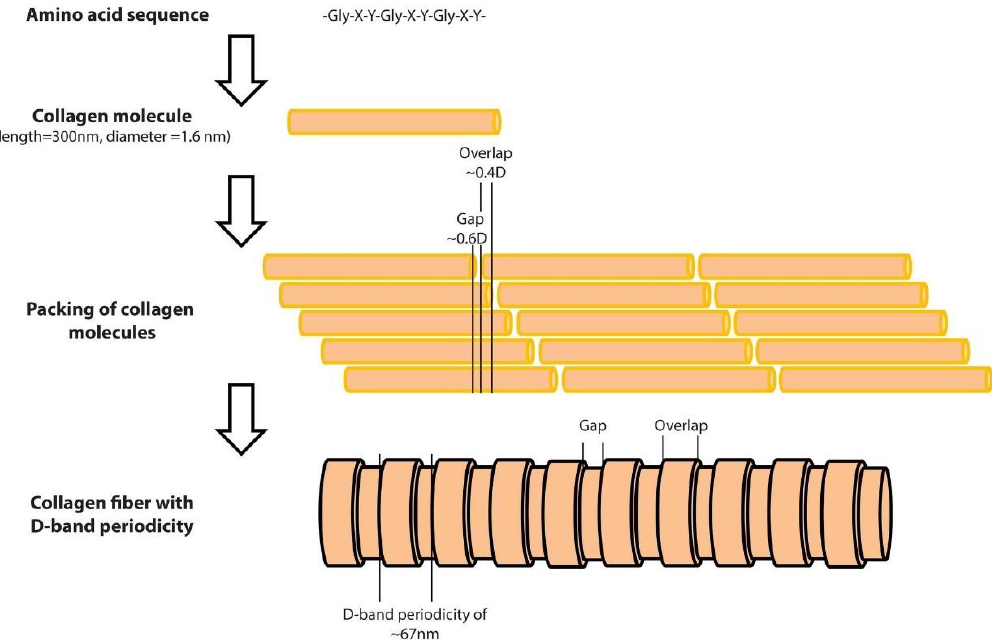
Figure 1. The structure of a collagen fiber type I, from the amino acid sequence to the D-band periodicity. As presented at the top of the figure, the collagen molecules consist of three amino acid chains. The length of the collagen molecule is 300 nm, while its diameter is 1.6 nm. The amino acid chains form rod-shaped triple helices which are assembled to form collagen molecules. Molecules are packed in a quarter-staggered fashion in order to form fibrils with a pattern that is known as the D-band periodicity. This pattern consists of overlapping and gap regions; it is a repeating banding pattern of about 67 nm as shown at the bottom of the figure.